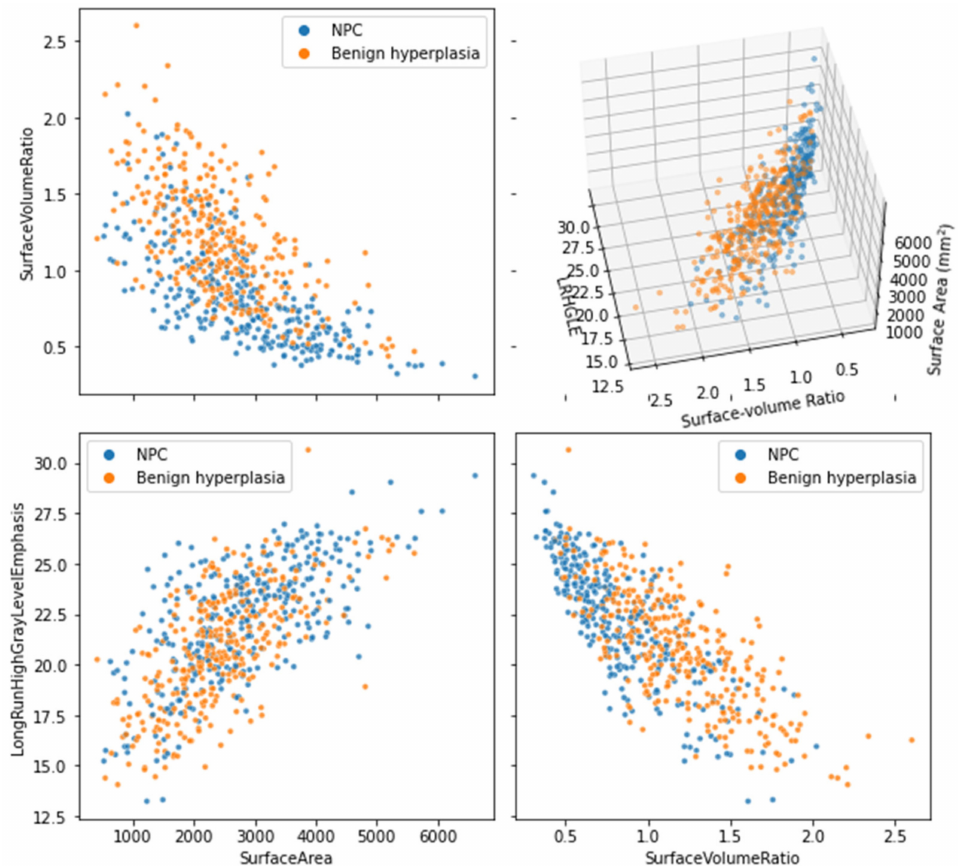
Figure 6. Scatter plots joining the three features: (i) surface–volume ratio, (ii) surface area, and (iii) long-run high-gray-level emphasis of local kurtosis extracted from all patients (i.e., lbp-3D-k, glrlm, LongRunHighGrayLevelEmphasis in PyRadiomics), including both the 3 T training and 1.5 T testing cohorts, which were consistently selected by the proposed BB-RENT method and which were assigned negative coefficients with highest magnitudes across all five folds in the model-training phase. These three features extracted from the T2-weighted, fat-suppressed MRI exhibited potential to discriminate early NPC from benign hyperplasia and were selected by BB-RENT from a total of 422 features. NPC = nasopharyngeal carcinoma, LRHGE = long-run high-gray-level